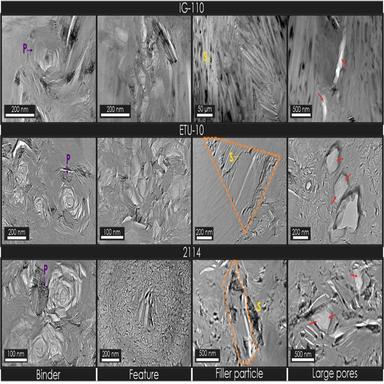
TEM micrographs of the phases and features of super-fine nuclear graphite grades. P – platelets, S – crystal strains. Red arrows indicate the presence of material inside the pores. (For interpretation of the references to colour in this figure legend, the reader is referred to the web version of this article.)